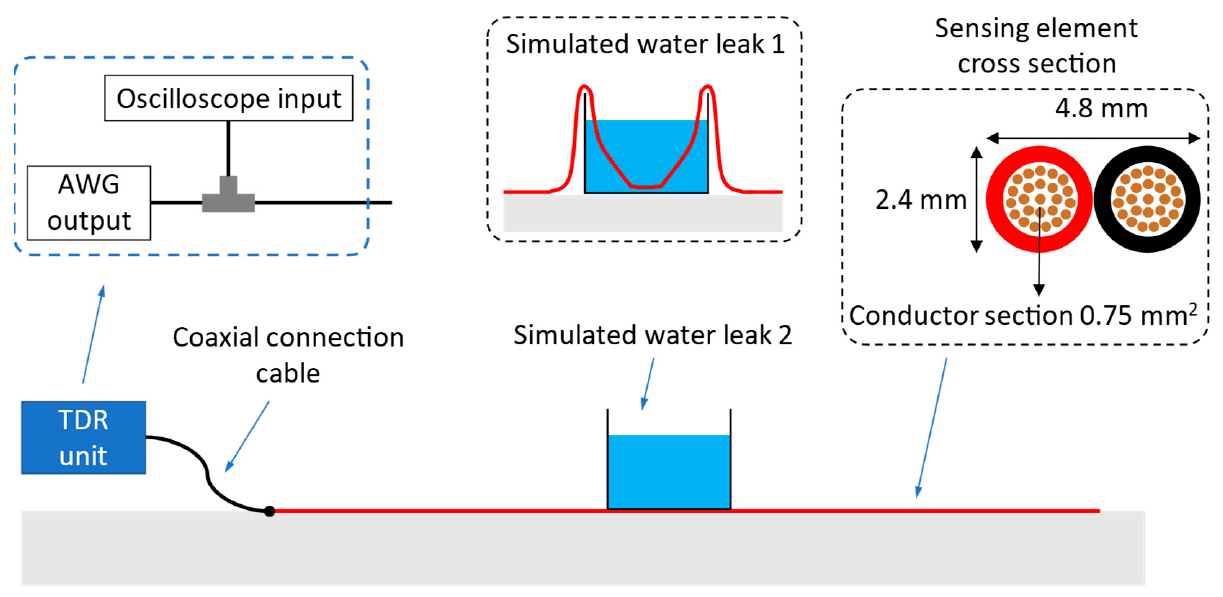
Figure 3. Representation of the laboratory measurement setup. The SE is placed on the floor and is connected to the TDR unit through a short coaxial cable.